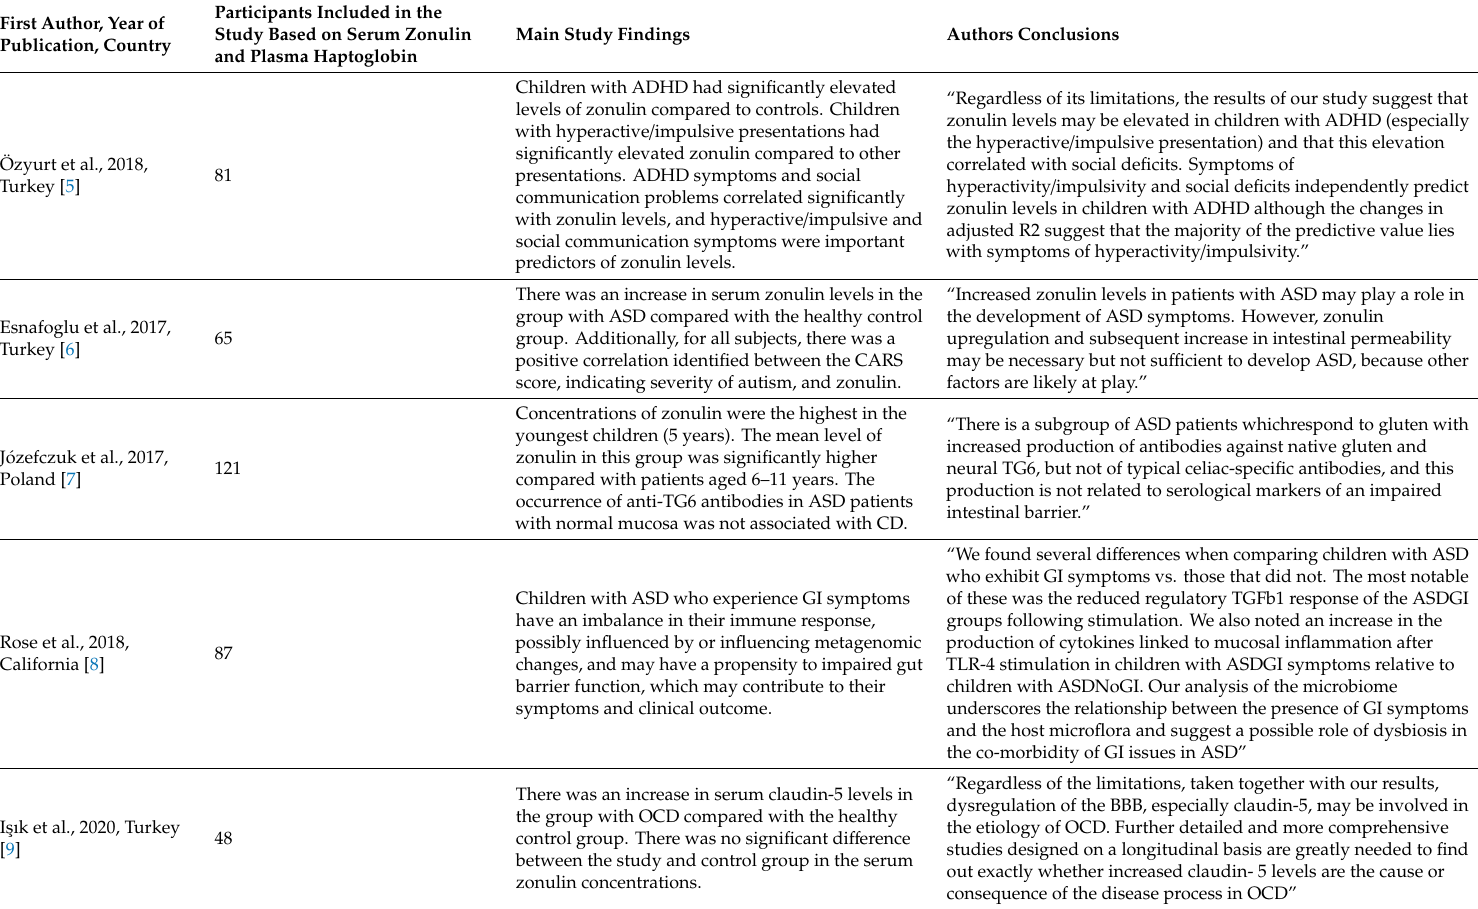
Table 4. Summary of main